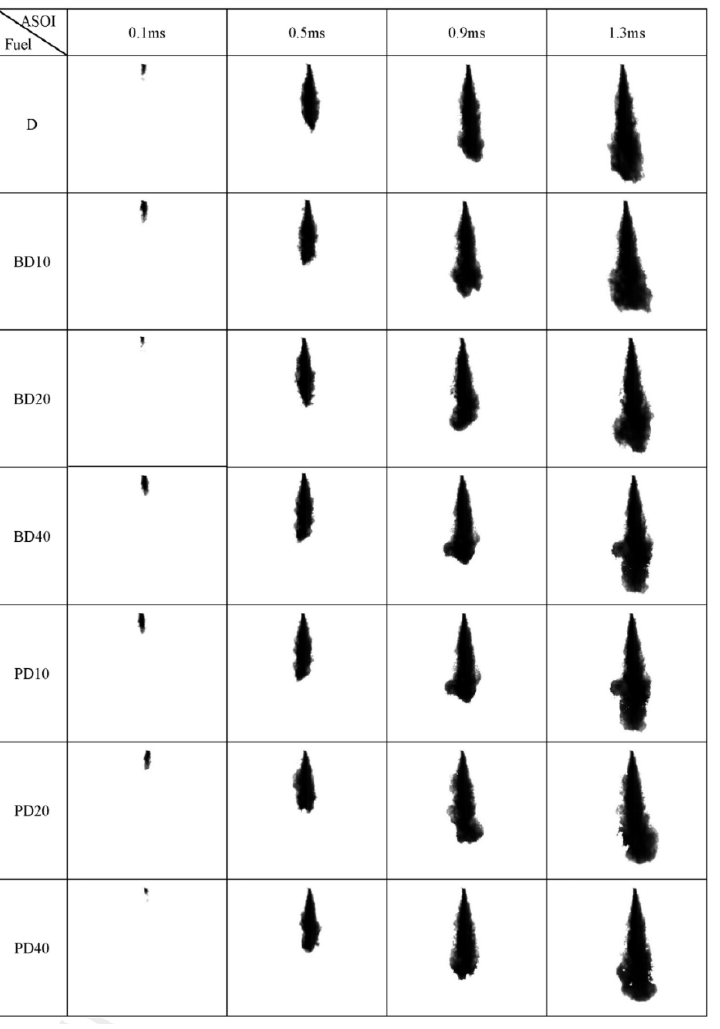
Figure 3. Processed spray profiles of long-chain alcohol-diesel fuels in a constant volume chamber for various time duration. Reprinted with permission from Ref. [51].